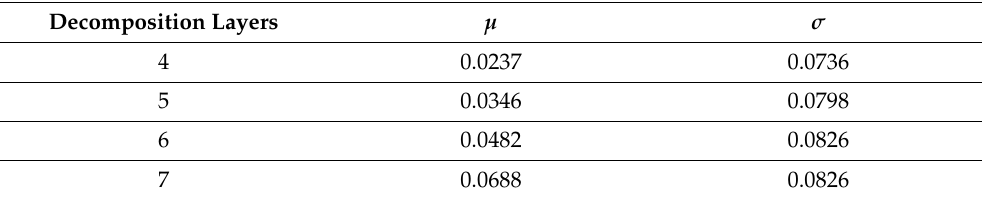
Table 1. Comparison of decomposition layers.